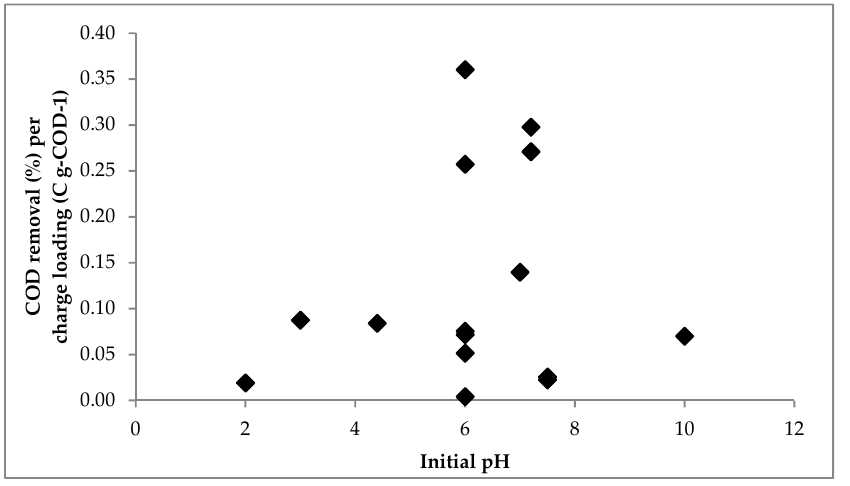
Figure 9. Comparison between initial pH and COD removal per charge loading in the EC of DSW.